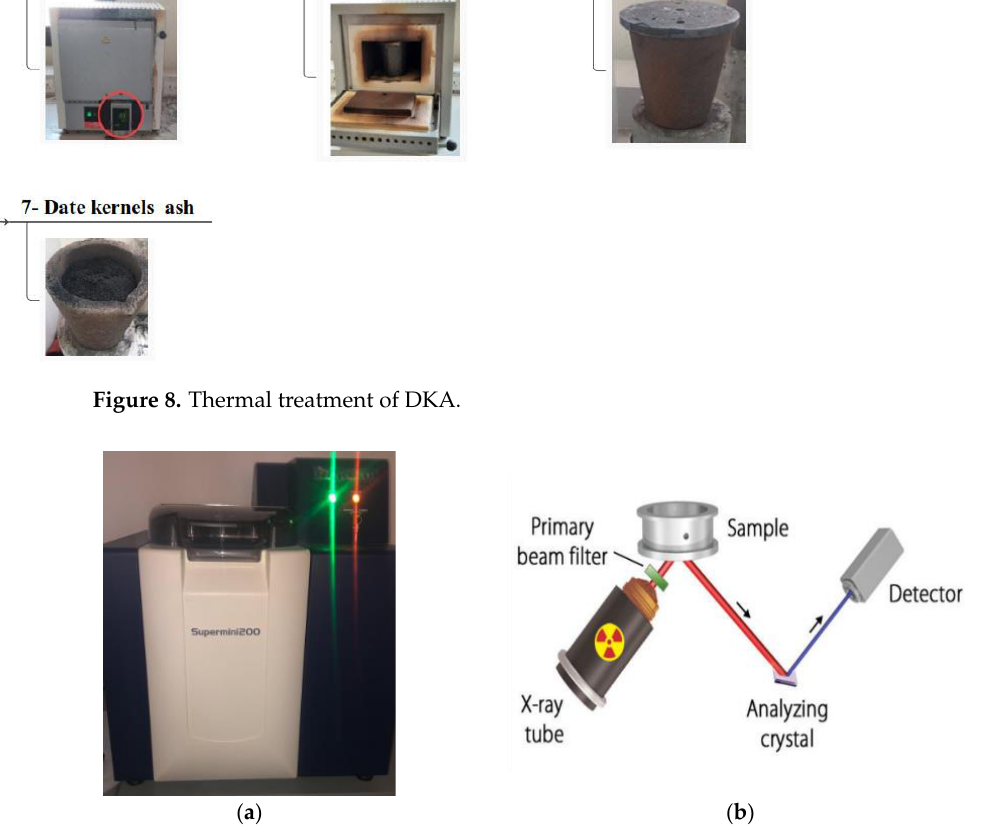
Figure 9. WDXRF analysis. ( a ) Supermini200 High-Power Benchtop Sequential WDXRF Spectrometer; ( b ) elemental analysis of specimens. Table 4. XRF analysis of DKA, NP, and FA.